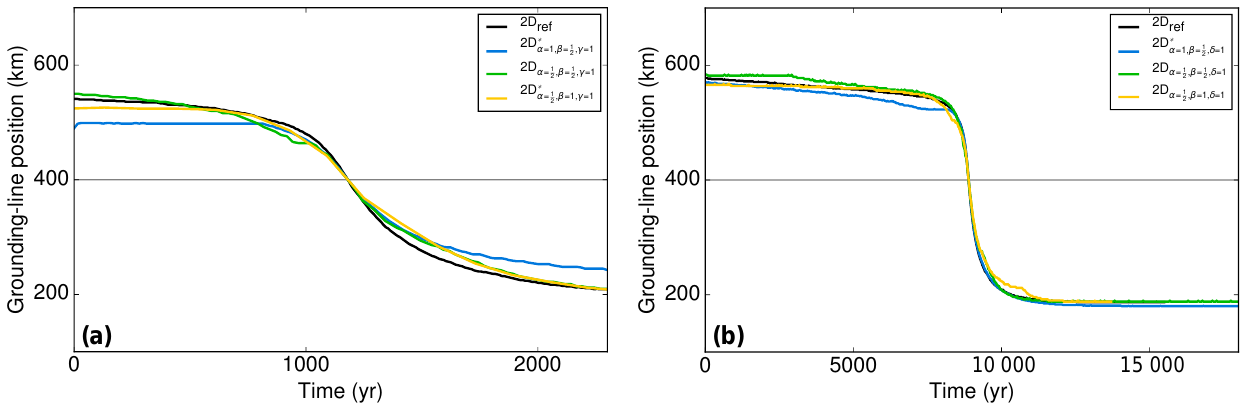
Figure D1. Scaled time series of grounding-line position for the reference and three geometrically scaled flow-line experiments with (a) identical basal friction and (b) identical surface mass balance, respectively. For better comparison the grounding-line curves are shifted along the time axis to overlap where the grounding line passes the minimum of the bed depression (grey horizontal line). Around this point the scaled curves of unstable grounding-line retreat approximately collapse into a single curve, indicating that the scaled speed of the grounding-line instability is approximately the same throughout the ensemble of scaling experiments. See Fig. 5 for unscaled version of this figure.